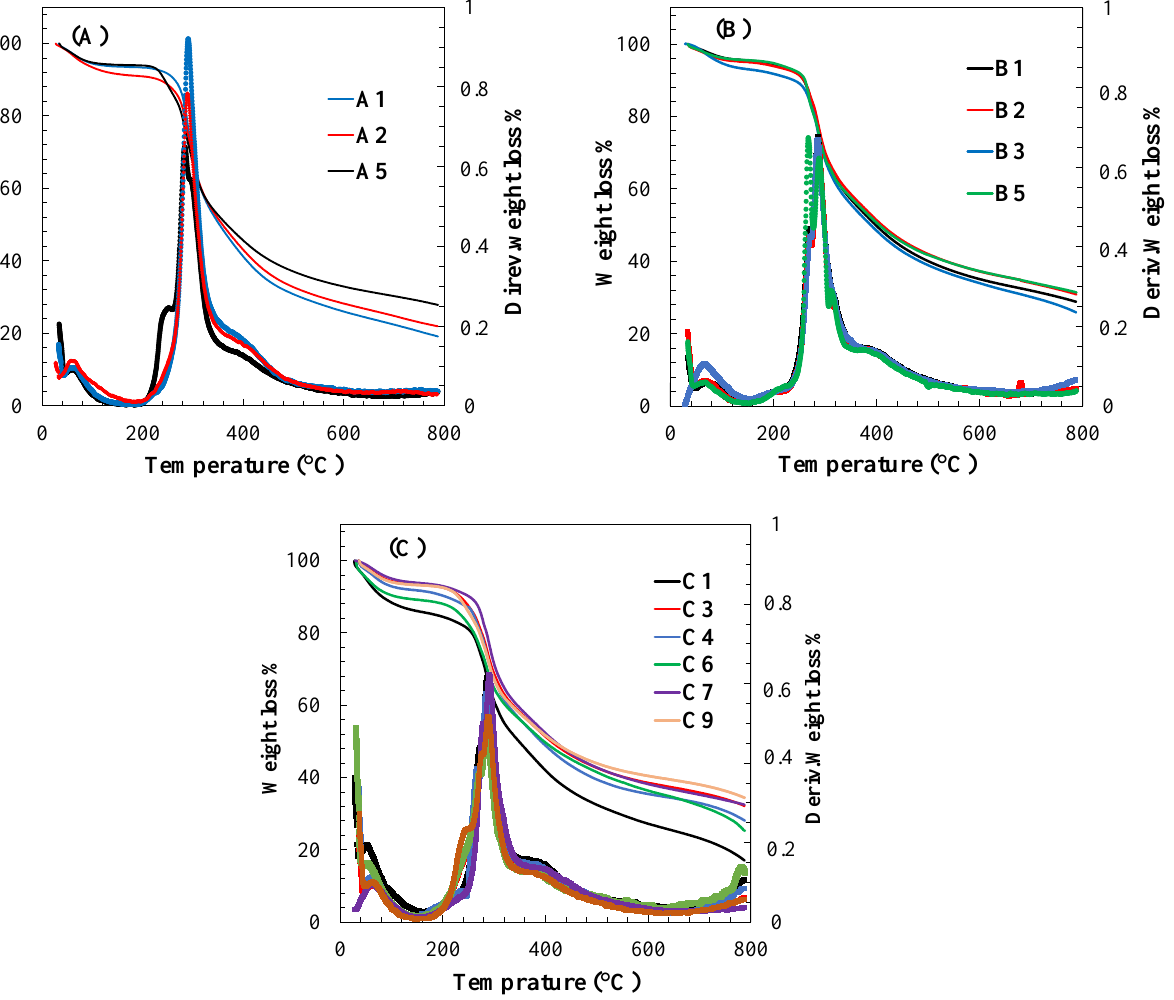
Figure 7. Thermogravimetric analysis (TGA) and differential thermal analysis (DTA): ( A ) SF/HA; ( B ) curcumin-loaded SF; and ( C ) curcumin-loaded SF/HA hydrogels.